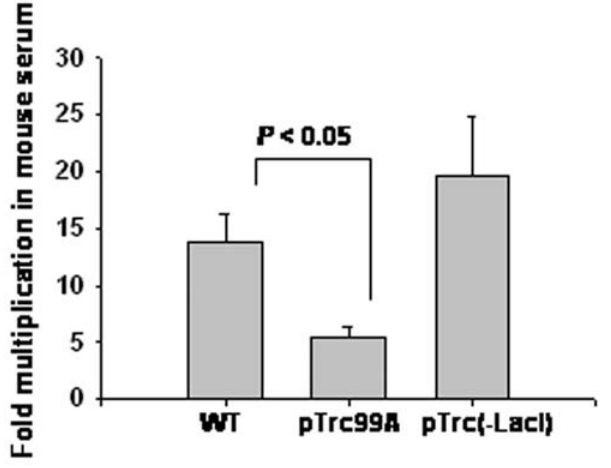
Figure 5. Sensitivity of S . enterica expressing LacI to mouse serum. Bacteria were grown in 96-well plates along with mouse serum as described in Materials and Methods for 4 h. Fold-replication was calculated by dividing the number of bacteria recovered after 4 h by the number of bacteria in the inoculum. Graph shown is a representative of three independent experiments done with triplicate samples.